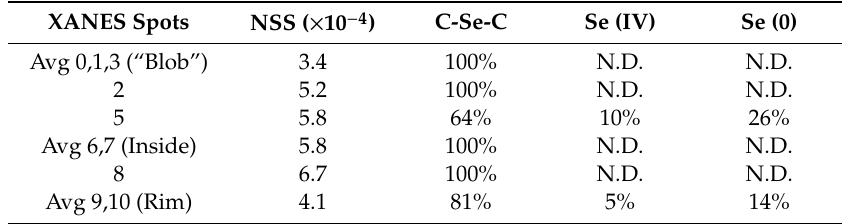
Table 3. Selenium speciation in seed #12 as determined by least-square linear combination fitting of the Micro X-ray absorption near-edge structure ( µ XANES) spectra collected at locations shown in Figure 2A. NSS = normalized sum of squares. C-Se-C may correspond to the organic forms SeMet, MeSeCys and / or Se-lanthionine, which are indistinguishable by µ XANES. Errors on fits are +/ − 10%. N.D: Not detected. Note: The spot 4 spectrum was too noisy to fit, so is not shown in the table. XANES Spots NSS ( × 10 − 4 ) C-Se-C Se (IV) Se (0) Avg 0,1,3 (“Blob”) 3.4 100% N.D. N.D. 2 5.2 100% N.D. N.D. 5.8 64% 100% N.D. N.D. 100% N.D.